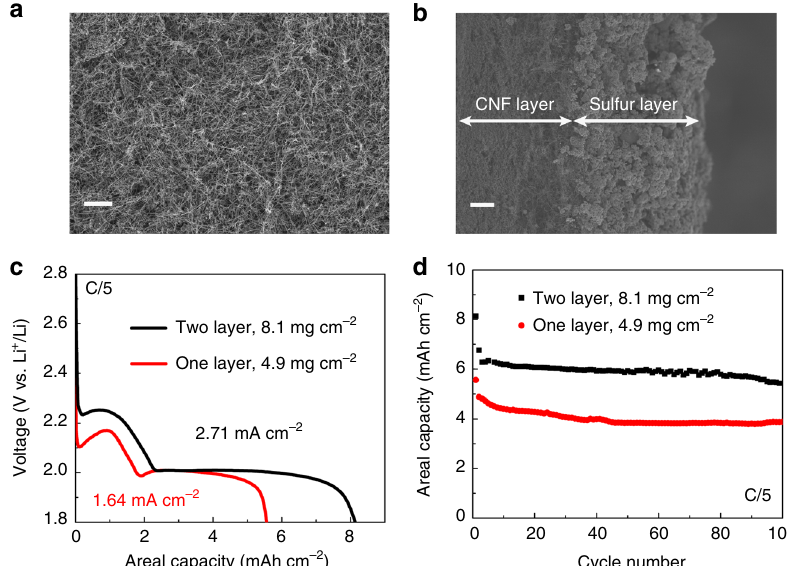
Fig. 5 High-loading Li – S cells with CNF current collector. a SEM image of the top surface of CNF current collector (scale bar = 10 µ m). b SEM image of the cross-section of the sulfur cathode with CNF current collector (scale bar = 20 µ m). c The 1st cycle discharge voltage pro fi les of the cells with one-layer or two-layer highly loaded sulfur cathodes deposited onto CNF current collectors. d Cycling performance of the cells with one-layer or two-layer CNF current collector sulfur